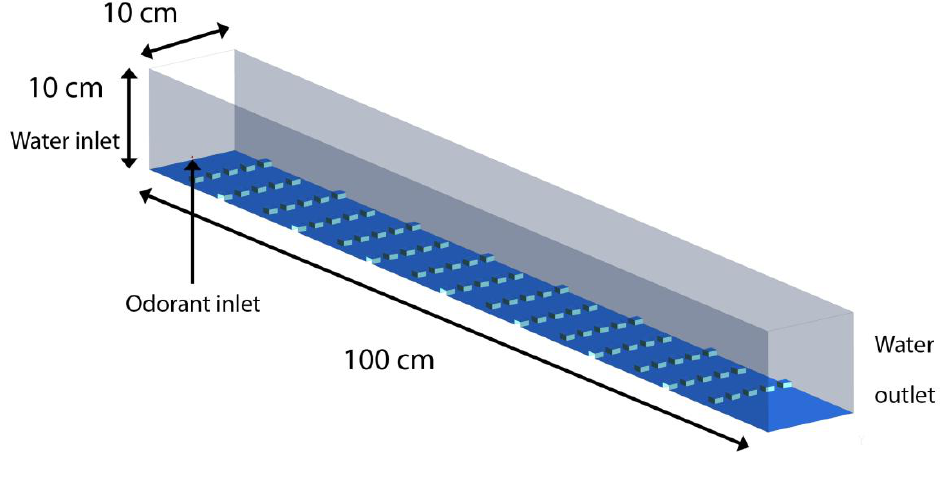
Figure 3. Schematics of the CFD domain for flow simulation. The bottom surface of the three-dimensional domain has cubical roughness elements placed in a staggered fashion. Water enters from the left end and exits from the right. The roughness humps at the bottom, of side length 1cm and separated by 5 cm from each other, help trip the boundary layer and facilitate mixing leading to a turbulent flow downstream. A stream of odorants is released into the inflow at the odorant inlet on the left at an elevation of z = 0.5 cm. The cubical humps have a base area of 1 cm by 1 cm and a height of 0.5 cm to hydraulically reproduce a sand bed